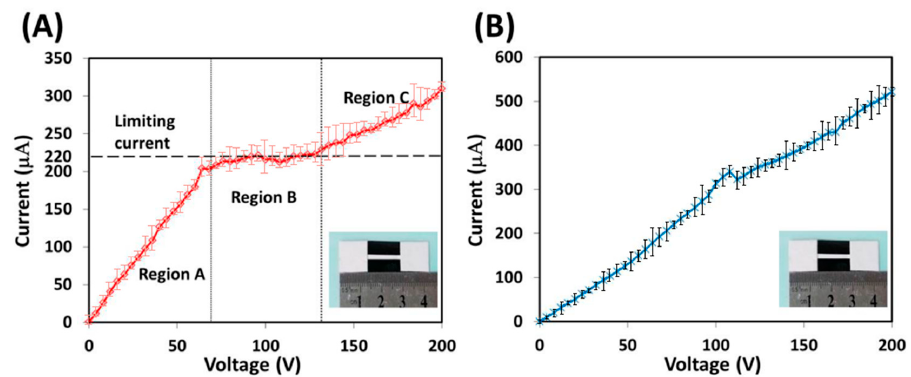
Figure 5. Current-voltage curves with two different types of ICP devices. ( A ) Type I; ( B ) Type II. The inset in A or B features a real ICP device.